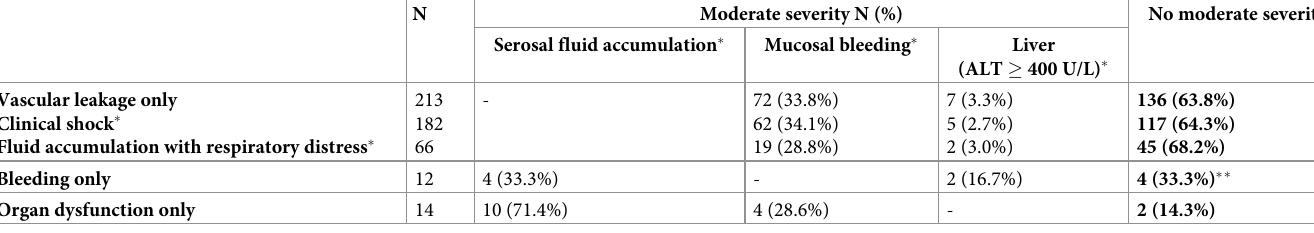
Table 4. Presence of moderate disease severity in 239 severe dengue patients who qualified for severe disease in one clinical category